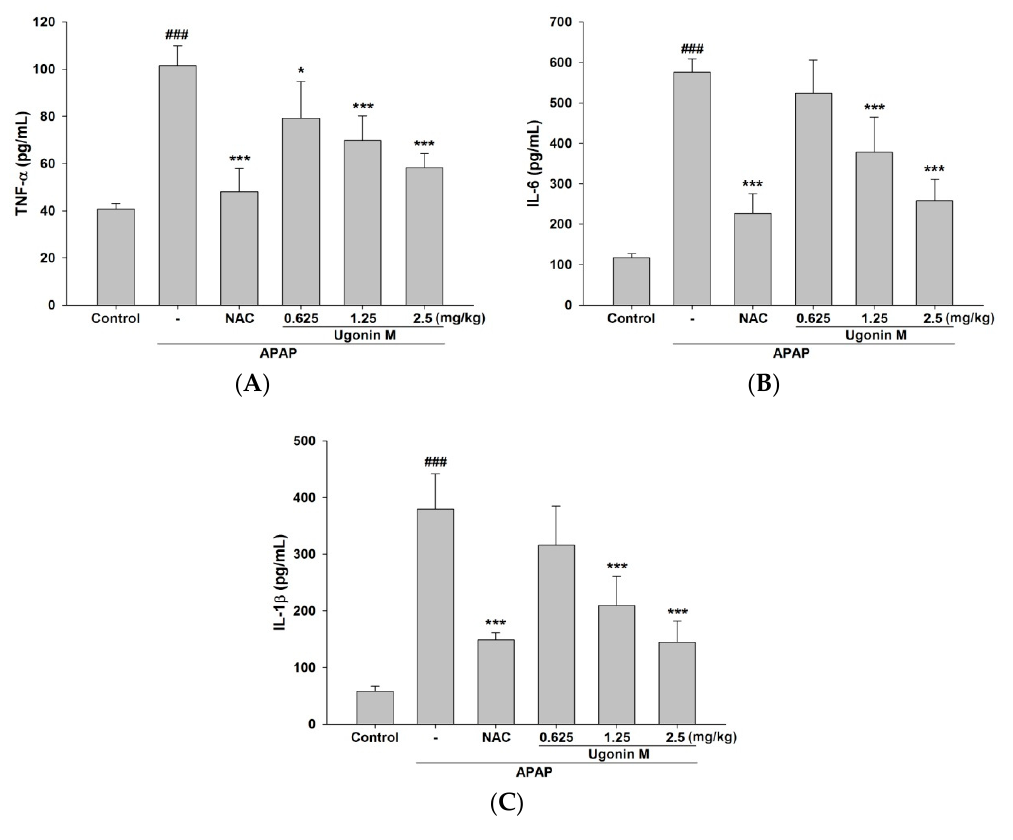
Figure 6. Effects of Ugonin M on serum ( A ) tumor necrosis factor- α (TNF- α ) , ( B ) interleukin (IL)-6, and ( C ) IL-1 β . Data are expressed as M ± SD; n = 6.